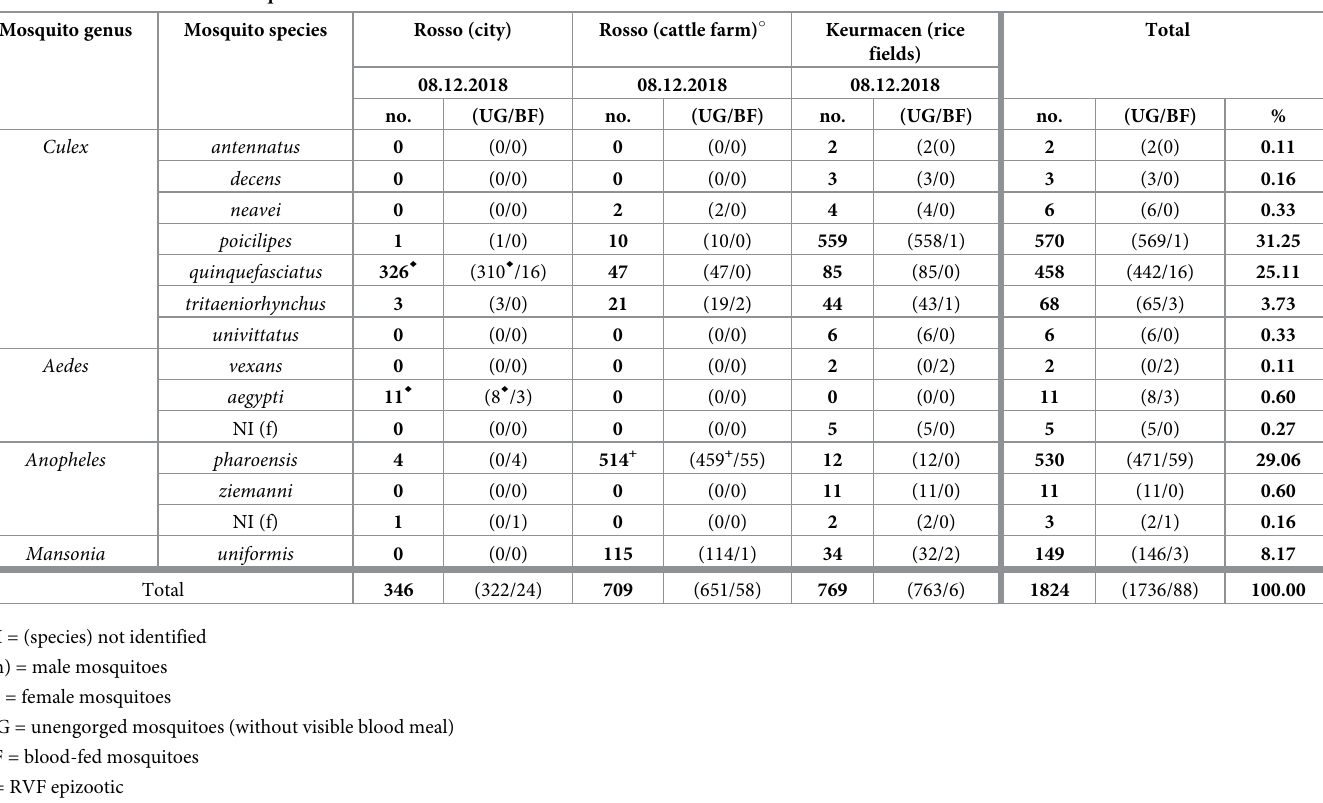
Table 4. Number of collected mosquitoes in Trarza.